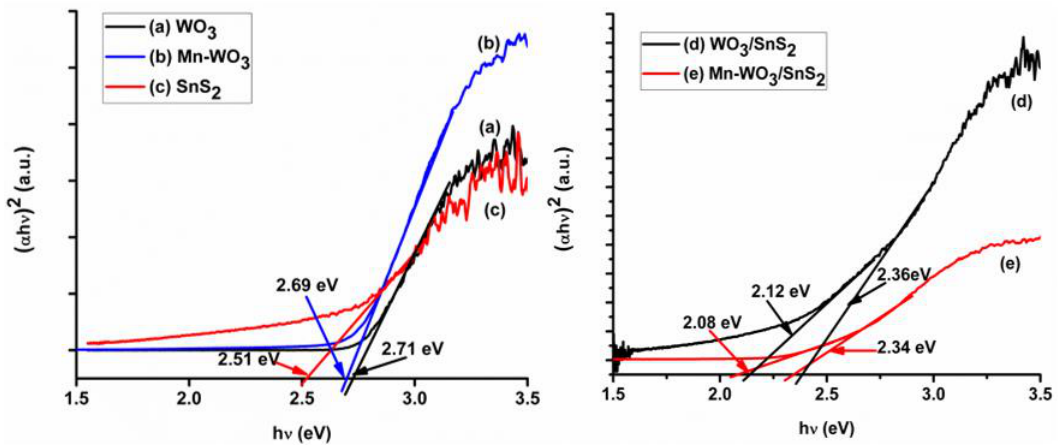
Figure 4. Tauc plots indicating the band gaps of ( a ) WO 3 , ( b ) Mn-WO 3 , ( c ) SnS 2 , ( d ) WO 3 / SnS 2 and ( e ) Mn-WO 3 / SnS 2 .